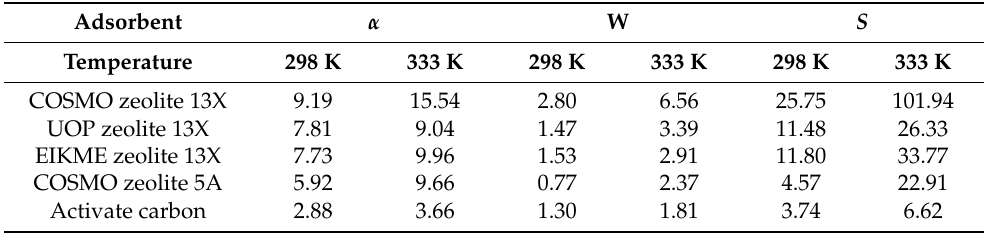
Table 8. Equilibrium selectivity ( α ), working capacities selectivity ratio (W), and selection parameter ( S ) of different adsorbents at 298 K and 333 K.